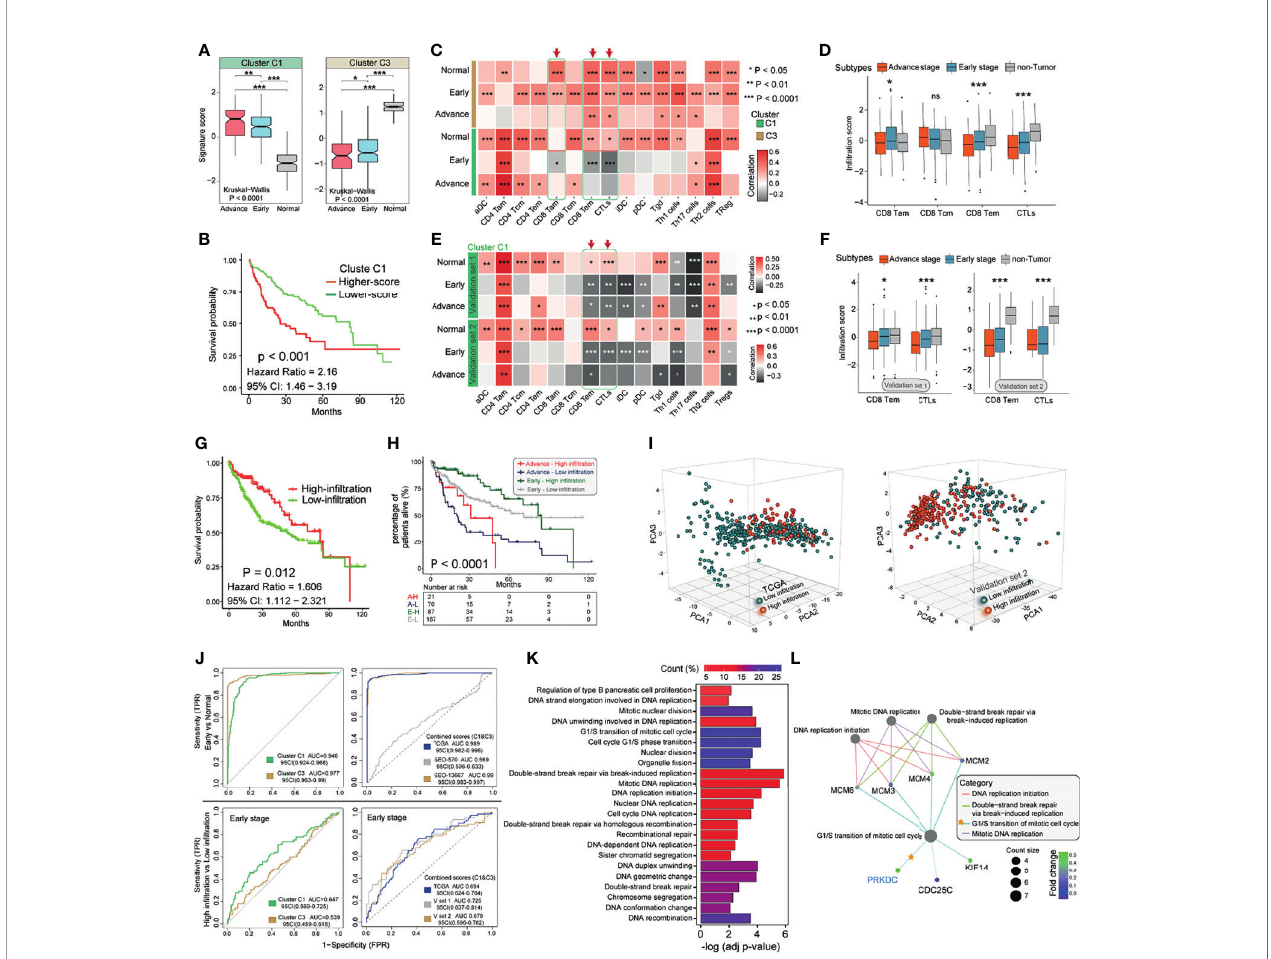
FIGURE 4 | Characteristics of Cluster signatures in HCC immune environment and biological functions. (A) Distribution of Cluster C1 and Cluster C3 signature scores in groups with different pathological stages (aHCC, eHCC, and non-tumor). The differences among groups were compared through the Kruskal – Wallis test (Kruskal – Wallis, p < 0.001). (B) Kaplan – Meier survival analyses of Cluster C1 signatures scores (log-rank test, p < 0.001). (C) Correlations between Cluster C1/C3 signatures and 15 types of immune cell in different pathological stages patients from TCGA. Negative correlation was marked with gray and positive correlation with orange. Red arrow indicates the potential immune cells associated with Cluster C1 signature. (D) The in fi ltration of CD8-Tam/Tcm/Tem and CTL immune cells in three HCC groups from TCGA. Within each group, the scattered dots represent immune cell prediction values. The lines in the boxes represent median value. The statistical difference of three groups was compared through the one-way ANOVA. (E) Correlations between Cluster C1 signature and 15 types of immune cells in different pathological stage patients form GEO. Data from validation set 1 (upper) and set 2 (lower) platform were used. (F) The in fi ltration of CD8-Tem and CTL immune cells in three HCC groups from GEO. Data from validation set 1 (left) and set 2 (right) platform were used. (G) Kaplan – Meier survival analysis of CD8-Tem/ CTL-based immune in fi ltration levels (log-rank test, p = 0.012). Red, high in fi ltration; green, low in fi ltration. (H) Kaplan – Meier curves for patients with eHCC/aHCC in TCGA cohort strati fi ed by CD8-Tem/CTL-based immune in fi ltration. Log-rank test shows an overall p < 0.0001. (I) Principal component analysis (PCA) for the transcriptome pro fi les of Cluster C1 genes in different immune in fi ltration patterns from eHCC and non-tumor samples. (J) ROC curves measuring the predictive value of Cluster C1, Cluster C3 (left), and combination of Cluster C1 and C3 (right) in eHCC diagnosis and CD8-Tem/CTL-related in fi ltration. (K) Functional annotation for Cluster C1 genes between different in fi ltration groups in eHCC patients. The color depth of the barplots represents the number of genes enriched. (L) Subnetworks that contain higher selective marker-regulated nodes implicated in the biological functions. The grade of the color represents the expression level of genes. Count size indicates the nodes enriched in each category. * p < 0.05; ** p < 0.01; *** p < 0.0001; ns, no signi fi cant difference. HCC, hepatocellular carcinoma; aHCC, advanced-stage hepatocellular carcinoma; eHCC, early-stage hepatocellular carcinoma; TCGA, The Cancer Genome Atlas; CTL, cytotoxic T cell; GEO, Gene Expression